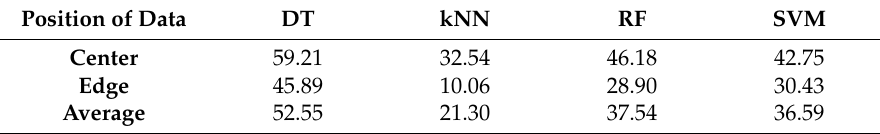
Figure 23. Detailed mean of positioning error comparison.